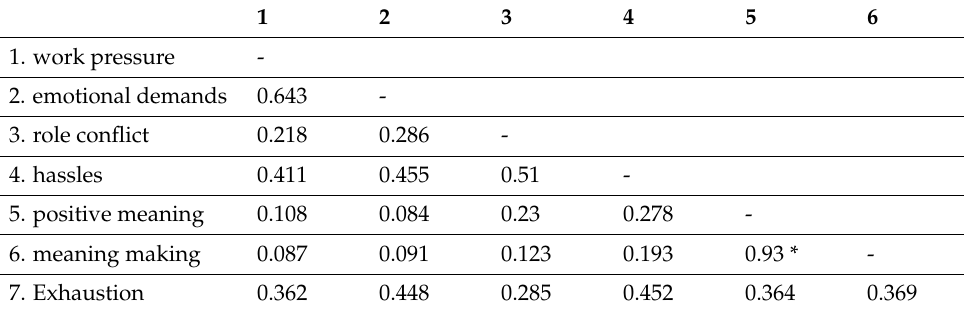
Table 3. Discriminant validity.